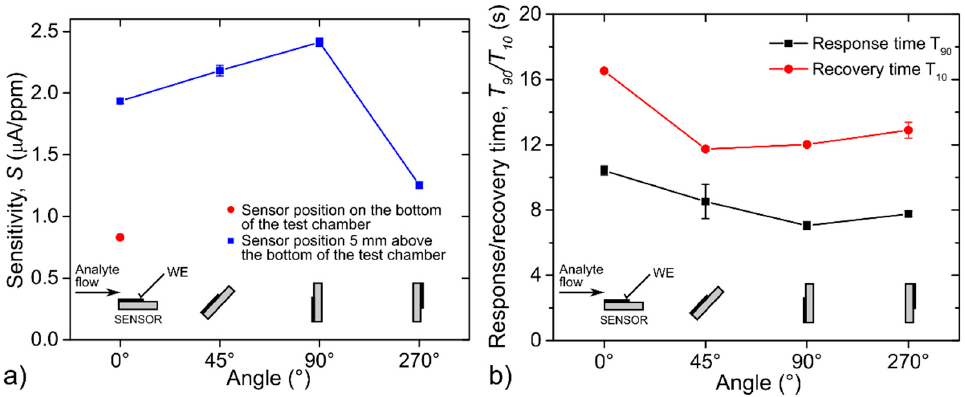
Figure 11. ( a ) Sensitivity dependence on the mutual orientation of the analyte flow direction and the WE surface area (22.4 mm 2 ); ( b ) response/recovery time dependence on the mutual orientation of the analyte flow direction and the WE surface area (22.4 mm 2 ); conditions: 298 K, 40 %RH, analyte flow rate 1 L/min. The error bars in Figure 11a represent the standard error of the slope of the calibration curve (sensitivity) that was constructed by linear regression. The error bars in Figure 11b represent standard error of the mean that was calculated from three consecutive exposures to the same concentration.